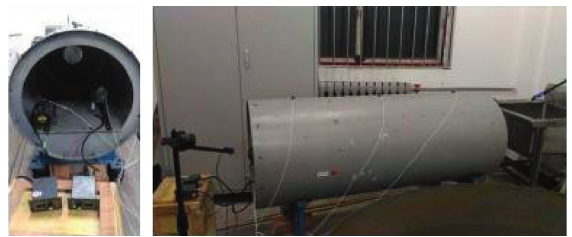
Figure 10: The test bench used for the experimental studies.